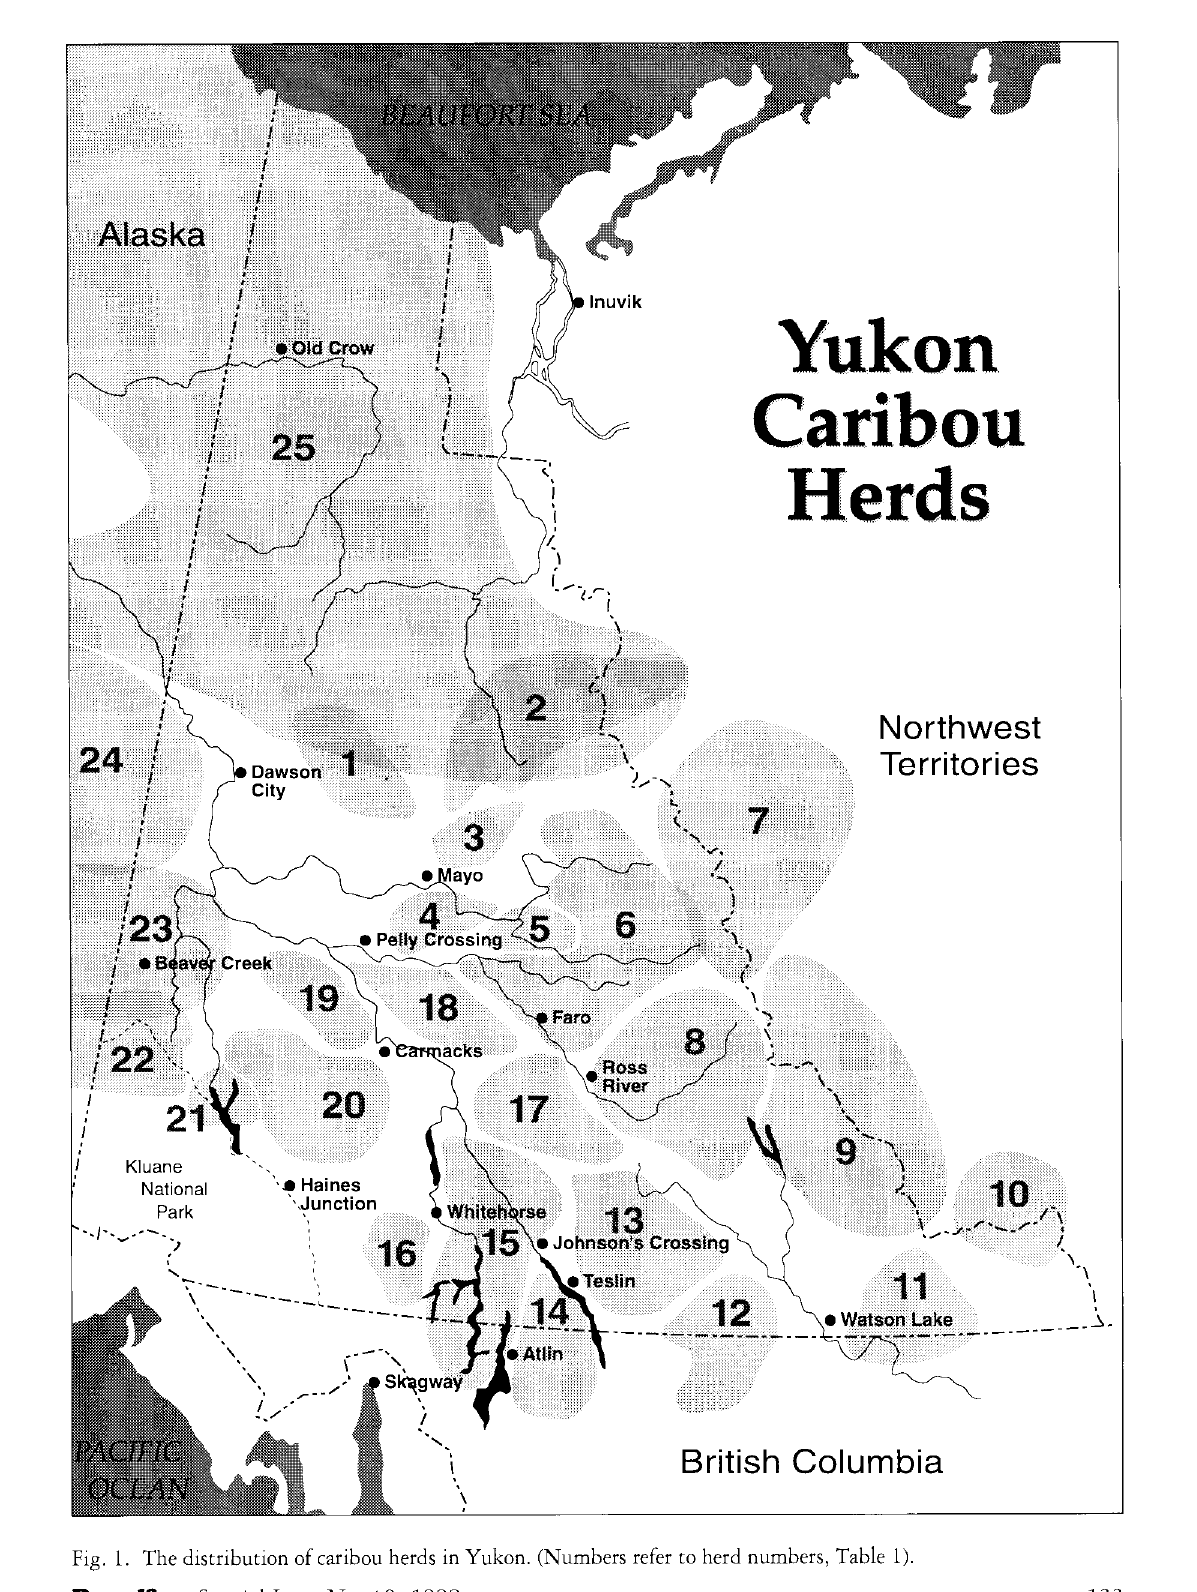
Fig. 1. The distribution of caribou herds in Yukon. (Numbers refer to herd numbers, Table 1). Rangifer, Special Issue N o. 10, 1998